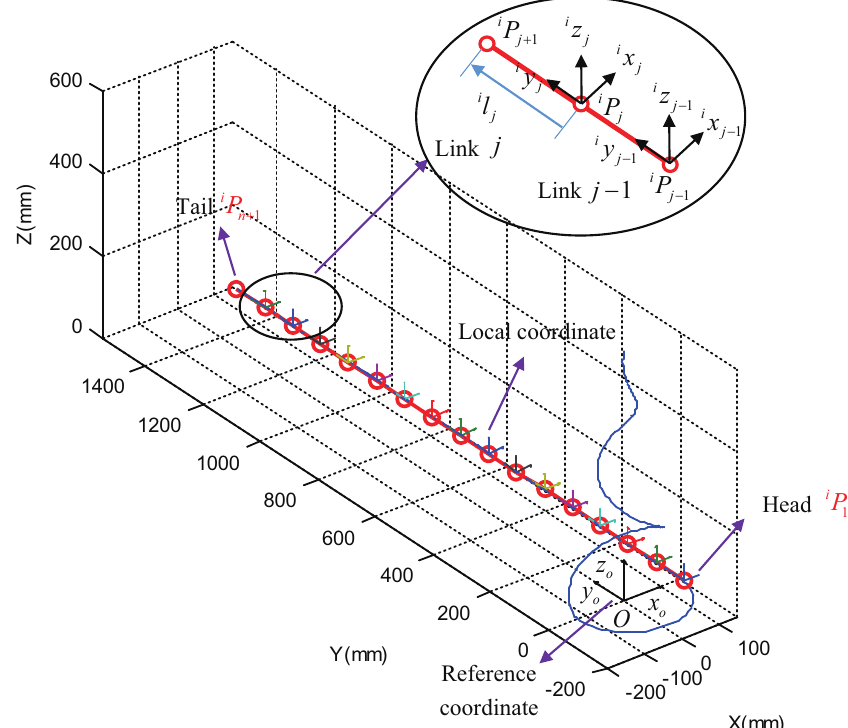
Figure 5. Modeling of the robot’s basic posture composed of n line segments and corresponding coordinate